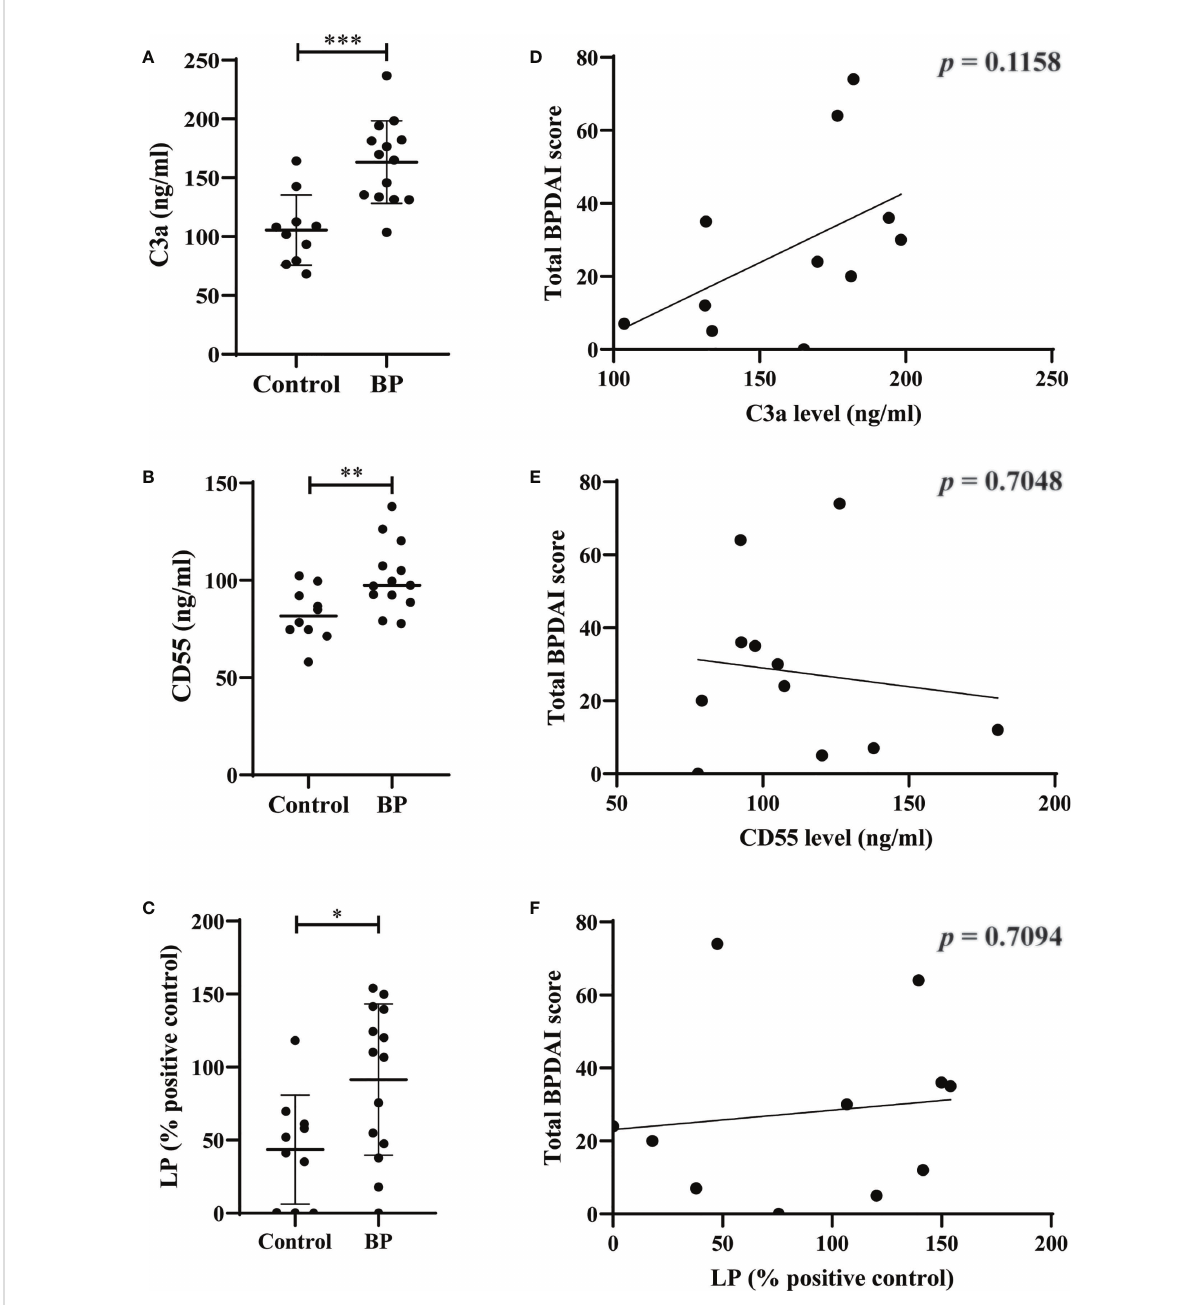
FIGURE 4 Elevated plasma levels of C3a and CD55 as well as elevated serum activity of mannose-binding lectin-pathway (LP) in patients with bullous pemphigoid (BP). (A-C) The plasma levels of C3a (A) , CD55 (B) , and serum activity of LP (C) in BP patients (n=10) were signi fi cantly increased compared to age- and sex-matched controls (n=10). (D-F) Plasma levels of C3a (D) , CD55 (E) , and serum activity of LP (F) in BP patients did not signi fi cantly correlate with disease activity as measured by the bullous pemphigoid disease area index (BPDAI). Differences between groups were analyzed by unpaired two-tailed t-test. *, p ≤ 0.05; **, p ≤ 0.01; ***, p ≤